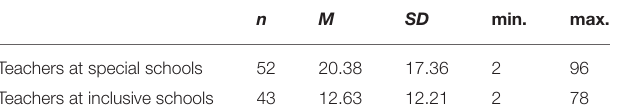
TABLE 3 | Number of students with SEN.